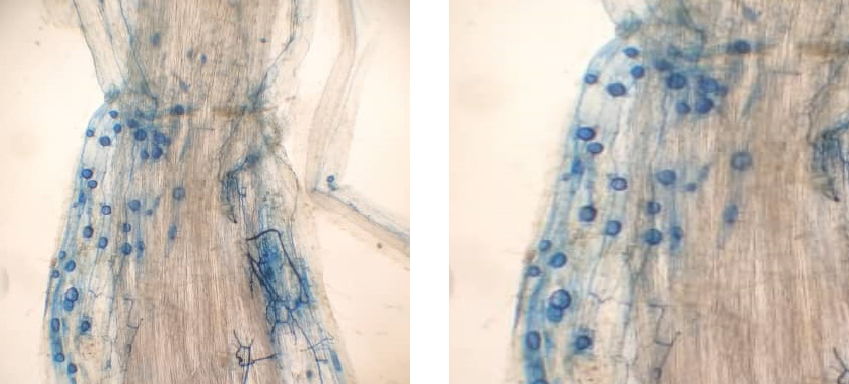
Figure 1. Images of root colonization by symbiotic fungi in the roots of lettuce .